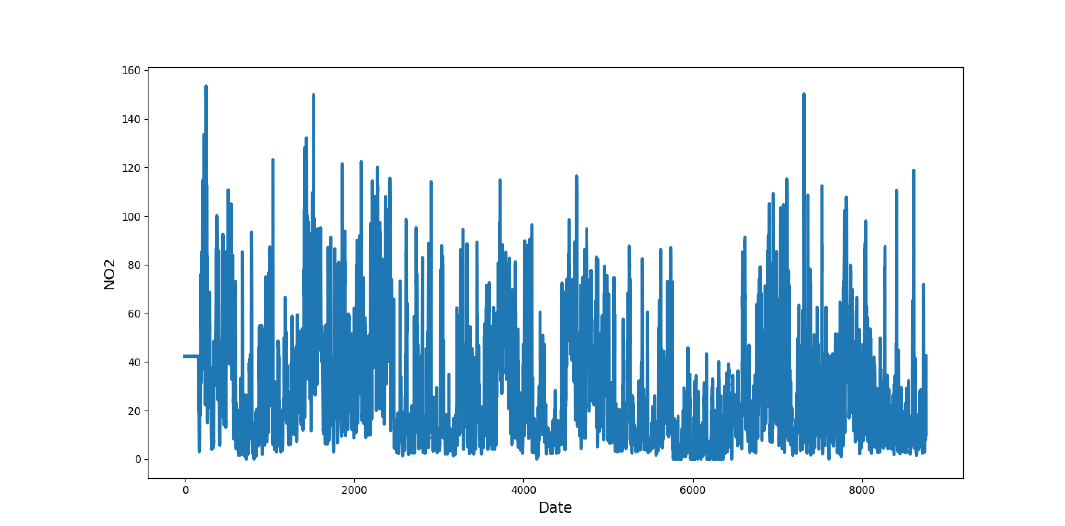
Figure 1. Individual time series of hourly NO 2 concentrations from Blanchardstown air quality monitoring station in Dublin, Ireland. Software: Python [57].